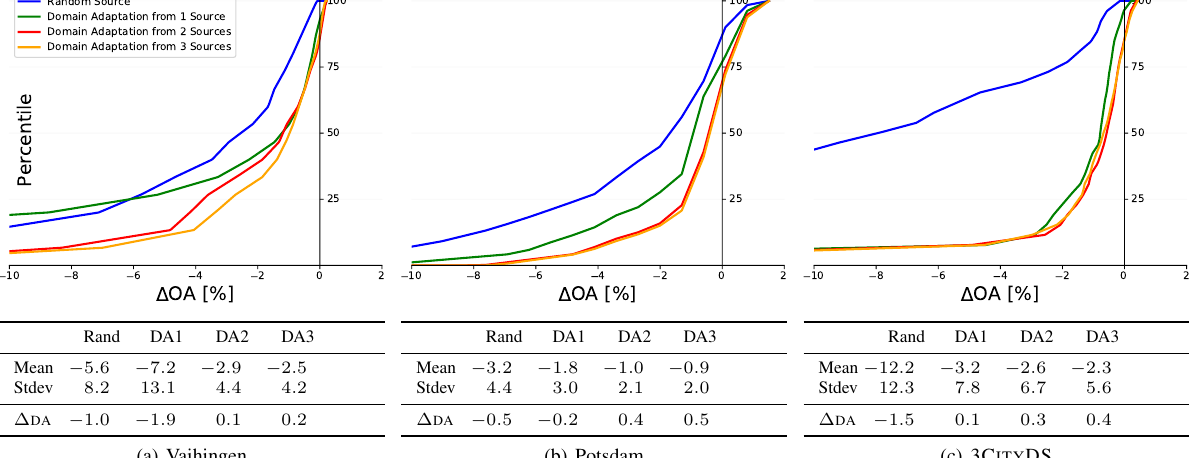
Figure 5. Domain adaptation results. ∆ OA presents the difference in OA after source selection and DA when compared to a classifier based on target training data. ∆ DA is the difference in OA between a classifier with and without DA being